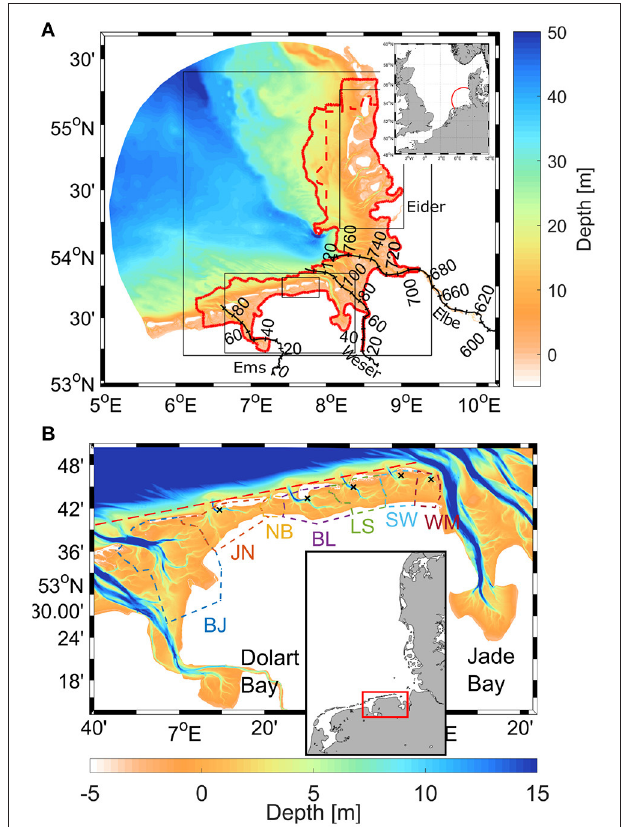
FIGURE 1 | (A) Mean bathymetry for the period from 1982 to 2012 in the German Bight. The inset shows the position of the German Bight in the North Sea. The thick red line delineates the area where time-referenced bathymetry is available. The space between the red dashed and full lines identifies the area where the time intervals between individual samplings is longer than 2 years on average. Numbers show the distance in kilometers along different rivers and their estuaries. Black boxes denote areas of interest shown in later analyses. (B) Magnified view of the area of the EFWS. Individual basins are separated by colored dashed lines and labeled after the names of the barrier islands behind which they are situated: BJ, Borkum Juist; JN, Juist Norderney; NB, Norderney Baltrum; BL, Baltrum Langeoog; LS, Langeoog Spiekeroog; SW, Spiekeroog Wangerooge; WM, Wangerooge Minsener Oog. The black crosses indicate the locations of tide gauge stations in the region. The red box shows the position of the magnified area. The brown dashed line to the north of the barrier islands identifies the open ocean area (to the north of this line), which is subject to a separate analysis.